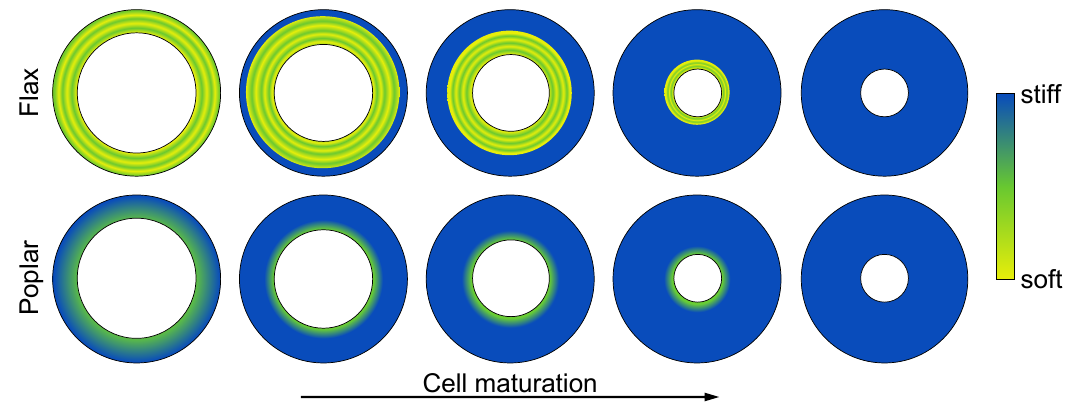
Cell Figure 9 : Comparative scheme of the maturation (thickening and stiffening) of the G-layer of flax and poplar.